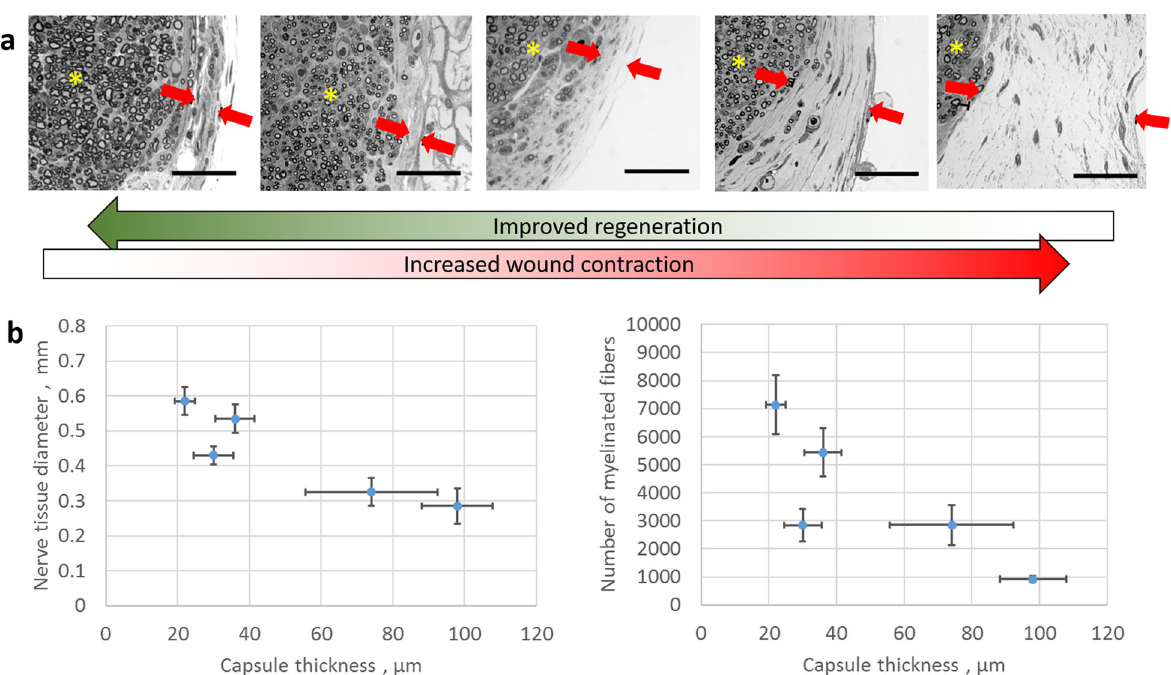
Fig. 2 An inverse relationship between wound contraction and induced regeneration was demonstrated in transected rat sciatic nerves grafted by a library of fi ve different porous collagen scaffolds, either DRT or analogs of DRT, differing only in degradation half-life. a OsO 4 staining of tissue sections reveals the formation of a contractile MFB capsule (thickness shown between red arrows) around the newly- formed nerve tissue (stars) 9 weeks post-injury. b Quanti fi cation of the inverse relationship between the intensity of wound contraction (assayed by the radial thickness of the MFB capsule) and quality of induced regeneration, assayed both by the equivalent tissue diameter (left) and the number of myelinated fi bers (right). Data (mean ± se) were obtained at the midpoint of the gap distance, 15 mm, initially separating the two nerve stumps, measured 9 weeks post-injury 20 . Scale bars 50 μ m. Figure 2a, b were reproduced with permission from Biomaterials, 33, 4783 – 91, © Elsevier (2012).